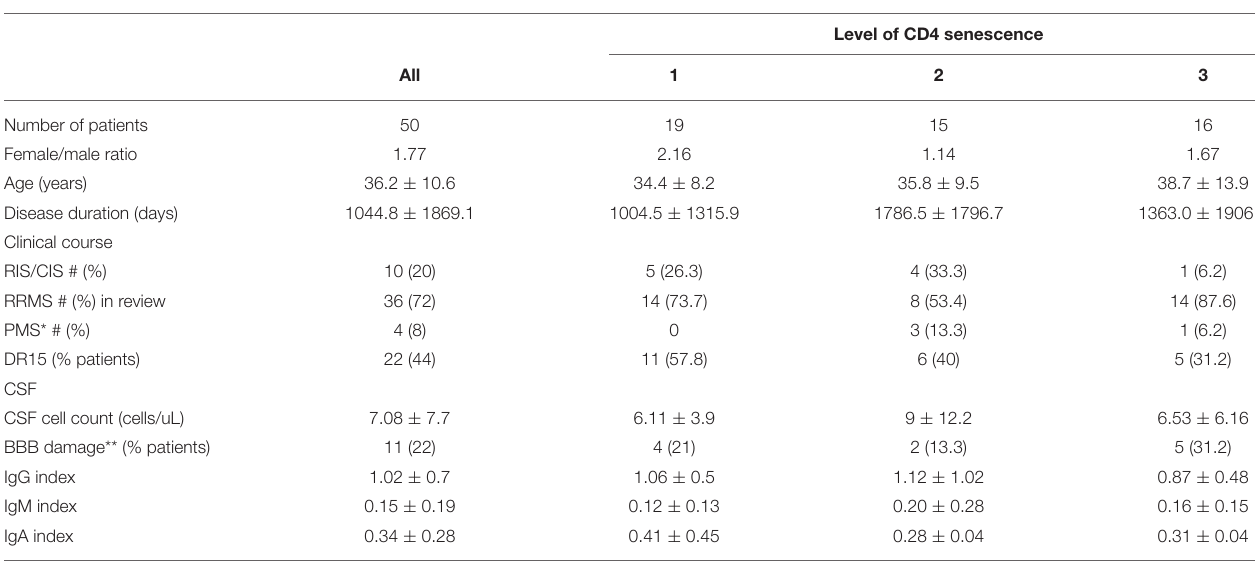
TABLE 1 | Demographic and clinical